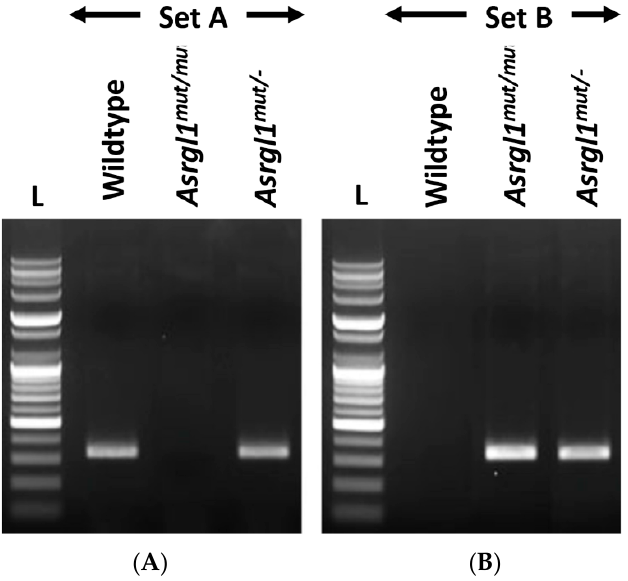
Figure 2. Gel electrophoresis of the Asrgl1 mut/mut mouse: ( A ) Set A primers amplified a 328 bp product without the 5 base insertion at c.578 position from wildtype and heterozygous Asrgl1 mut/ − alleles. ( B ) Set B primers amplified a 333 bp product from the homozygous and heterozygous Asrgl1 mut/ − alleles. Table 1. Primer sequences for the Asrgl1 mut/mut mice genotyping.